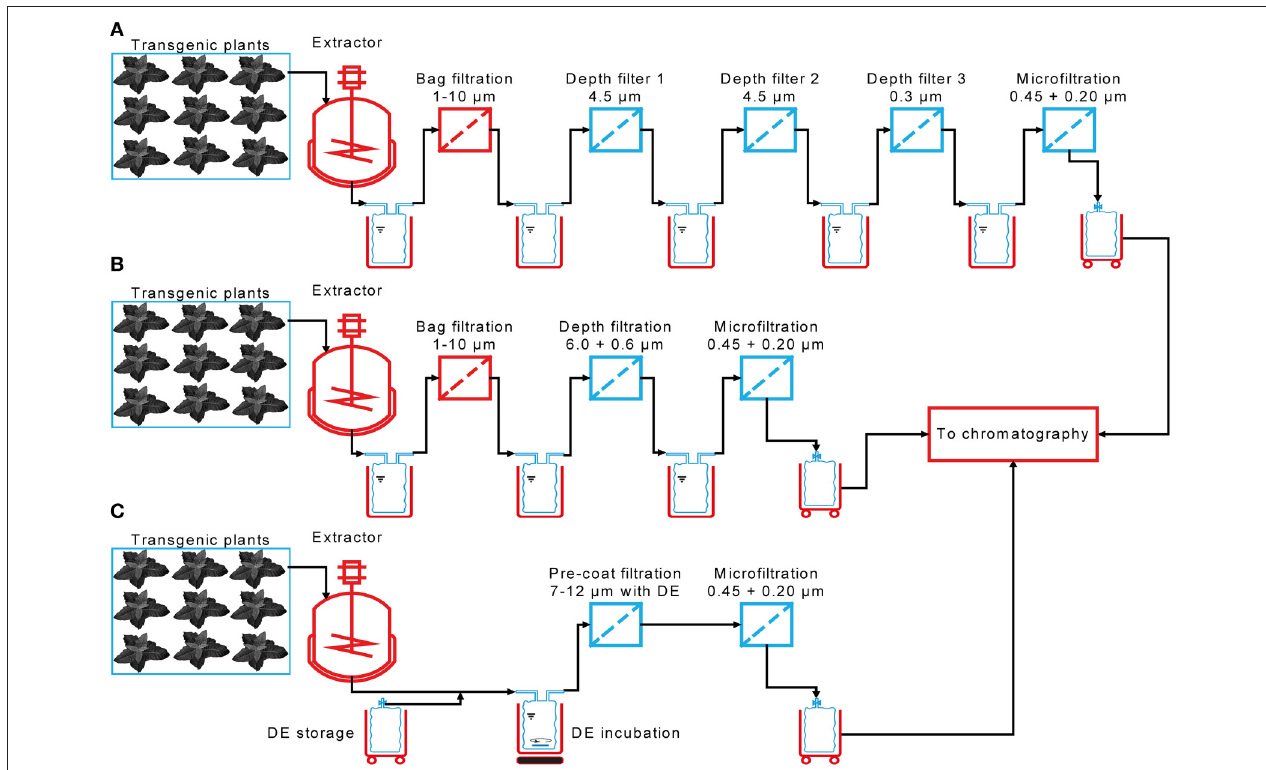
FIGURE 1 | Incremental reduction in the complexity of a process for plant extract clarification. (A) The clarification process implemented for the manufacture of the plant-derived antibody 2G12 under GMP conditions in 2009 consisted of a total of five filtration steps, including three depth filters. (B) The filter train complexity was reduced as part of a new production campaign in 2013/2014, now consisting of three filtration steps and two multi-use components. (C) In the current process, a pre-coat filtration step replaces the bag and depth filters, reducing both the number of filtration steps and the number of multi-use components.